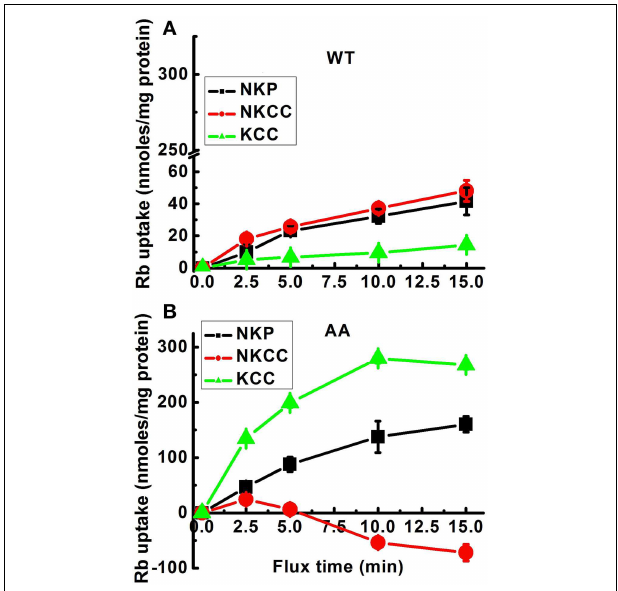
FIGURE 2 | Effect of constitutive KCC3 Thr991/Thr1048 dephosphorylation on KCC3, NKCC1, and NKP activity as a function of flux time. Rb + influx assays in isogenic cell lines harboring inducible expression of either KCC3 wild type (WT) (A) or KCC3 Thr991A/Thr1048A (AA) (B) were performed as described in Methods. Rb + uptake was determined in the following media: total uptake, Cl − alone (Cl), Cl − + ouabain (ClO), Cl − + ouabain + bumetanide (ClOB), S + ouabain + bumetanide (SOB). NKP, NKCC, and KCC represent the Rb + influx through the corresponding transporters. Data for WT (A) were represented in the same scale as for AA (B) cells to show the quantitative difference in Rb + uptake between these two types of cells. Shown are 2 independent experiments, n = 9 individual determinations for WT cells and n = 4 individual determinations from a single experiment for AA cells. Total number of independent experiments, N = 3 for both WT and AA cells. Data represent the mean ± SEM values. See legend to Figure 1 for further